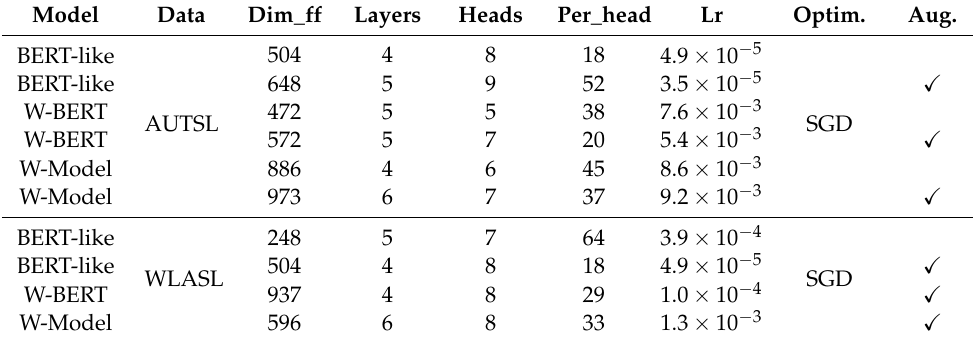
Table 2. Optimal settings for neural ensembler. Model Data Dim_ff Layers